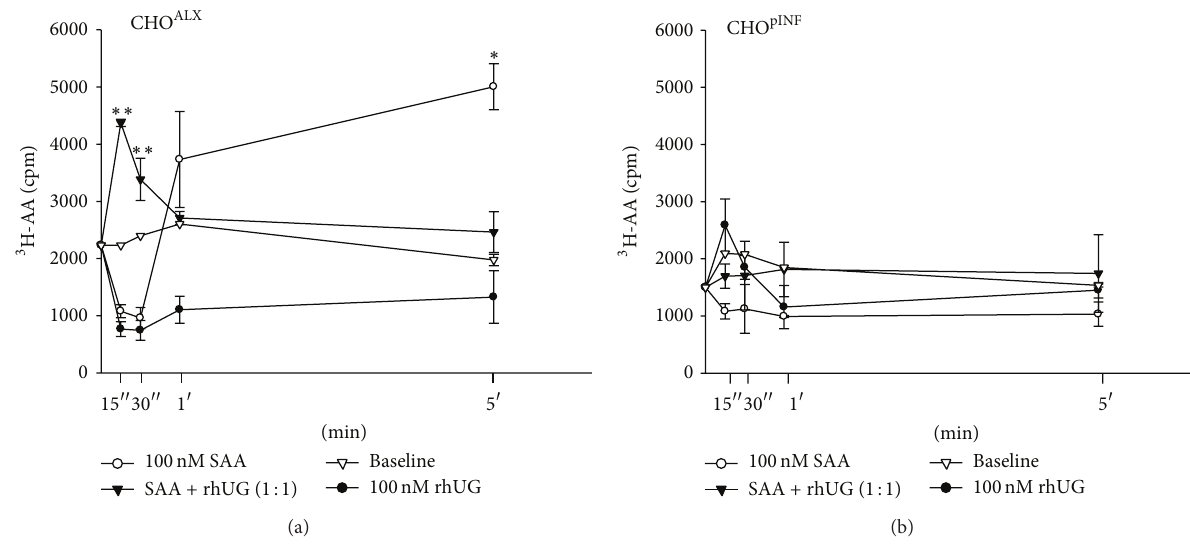
Figure 2: SAA-induced phospholipase A 2 activity is attenuated by UG in CHO cells overexpressing ALX. Time response of SAA-induced PLA 2 activity in CHO ALX cells (a) over a 5-minute monitoring period in the presence and absence of UG, as compared to mock transfected CHO cells (b). Significance is noted by Student’s 𝑡 -test of SAA treatment versus SAA + UG treatment. ∗ for 𝑃 < 0.005 and ∗∗ for 𝑃 < 0.001 . Results represent the mean ± SD of four separate experiments with triplicate